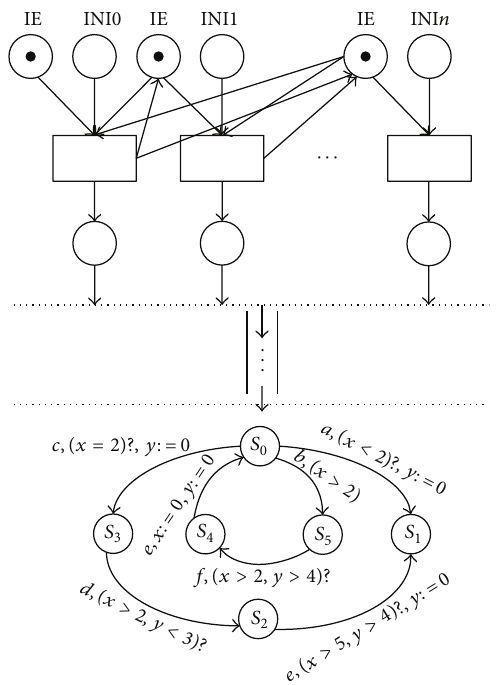
Figure4:Queuingtheorymodelofthewirelesssensornetworkwith 𝑛 communication task’s scheduling.